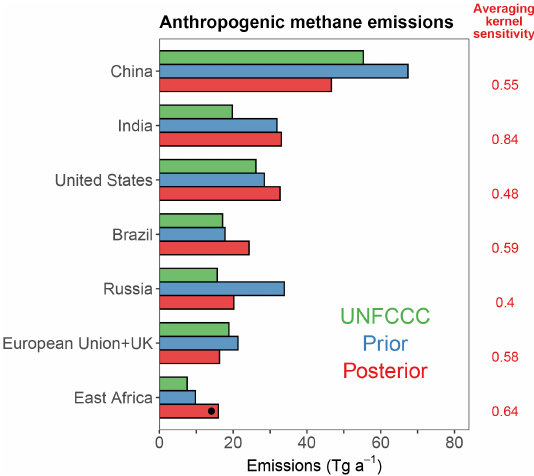
Figure 8. National and regional estimates of 2010–2018 mean methane emissions from anthropogenic sources. Included are the top five individual countries in our posterior estimates, the Euro- pean Union (including the United Kingdom), and East Africa (in- cluding Mozambique, Zambia, Tanzania, Ethiopia, Uganda, Kenya, and Madagascar). The UNFCCC record is from https://di.unfccc.int (last access: 10 July 2020). Non-Annex I countries do not report yearly emissions to the UNFCCC, and for those we use the latest UNFCCC submissions (Brazil, 2015; China, 2014; Ethiopia, 2013; India, Madagascar, Kenya, 2010; Uganda, Zambia, 2000; Mozam- bique, Tanzania, 1994). Inset are the averaging kernel sensitivities for these national and regional aggregated results, which measure the ability of the observations to constrain the posterior solution (0: not at all, 1: fully). The dot for East Africa represents the estimate inferred from a sensitivity inversion with the prior spatial distribu- tion of African wetlands